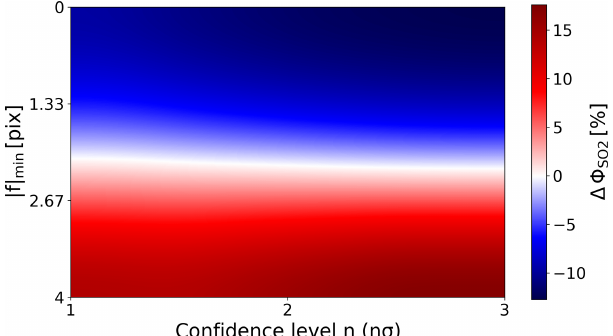
Figure B4. Sensitivity of SO 2 emission rates as a function of the chosen input settings | f | min ( y axis) and the confidence level n ( x axis). The investigated value ranges are 0–4 pixels for | f | min and 1–3 for the n and the deviations are plotted as percentage devia- tions (cid:49)(cid:56) SO from the average SO 2 emission rate retrieved from 2 this study. The latter amounts to 2 . 4kgs − 1 (not dilution corrected; see text). The analysis was performed using the average SO 2 emis- sion rates retrieved from 30 images of the Etna data